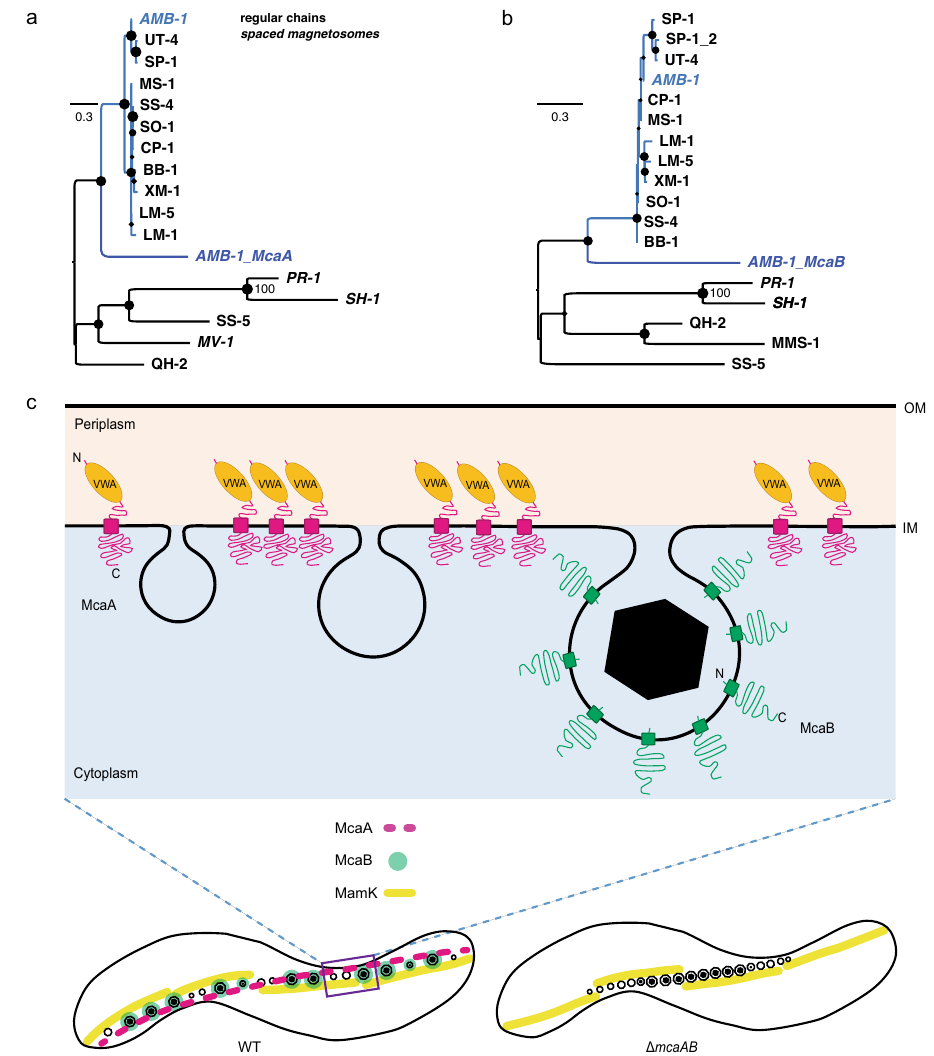
Fig. 9 | Phylogenetic analysis and model of McaAB-mediated magnetosome chain assembly. a , b Maximum likelihood trees showing the ancestry of McaA ( a ) and McaB ( b ) proteins in relation to their homologs in freshwater magnetotactic Rhodospirillaceae (blue clade) and the external groups of other Proteobacteria . All strains ’ accessionnumbersaregiveninSupplementaryDataset1.Treesweredrawn to scale and branch length refers to the number of substitutions per site. Robust- nessoftheinternalbranchesissymbolizedbyacirclewhosesizeisproportionalto the bootstrap value estimated from 500 nonparametric replicates. The magneto- some chains in these strains were previously characterized. If magnetosomes are spacedfromeachothersimilarlytostrainAMB-1,namesareinitalics. c